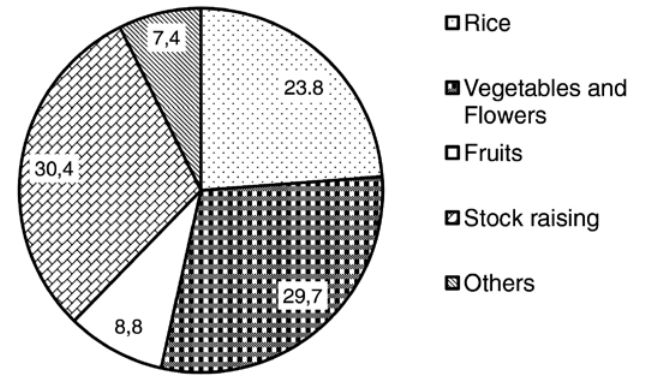
2 - Proportion of each sector for total agricultural production in